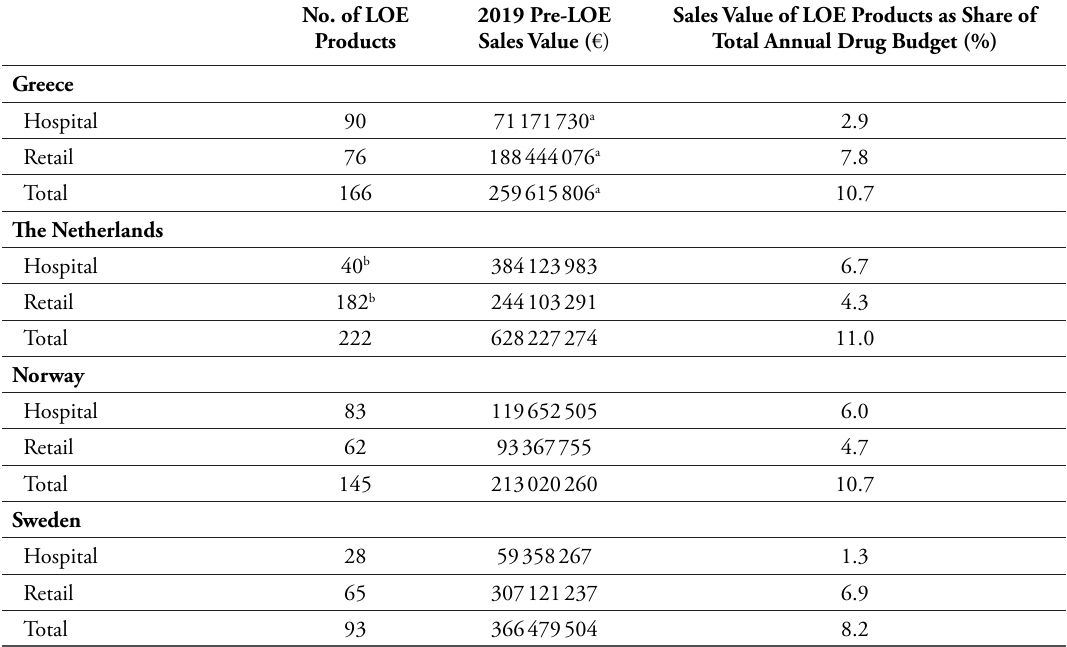
Table 2. Number of LOE Products, Sales Value of LOE Products, and Pre-LOE Sales Value of LOE Products as a Share of the Annual Drug Budget